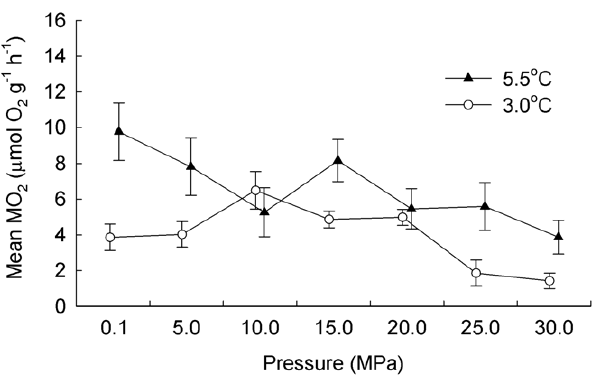
Figure 2. Acclimation, temperature and pressure effects on the rate of oxygen consumption of Stephonyx biscayensis . In the absence of an effect of acclimation to atmospheric pressure on the interaction of temperature and pressure effects, unacclimated and acclimated treatments were pooled. The effect of temperature on the relationship between pressure and mean ( 6 1 s.e.) rate of oxygen consumption (MO 2 ) of fed Stephonyx biscayensis is shown (10 individuals per data point); treatments are offset for clarity and no treatments differ significantly from 0.1 MPa.